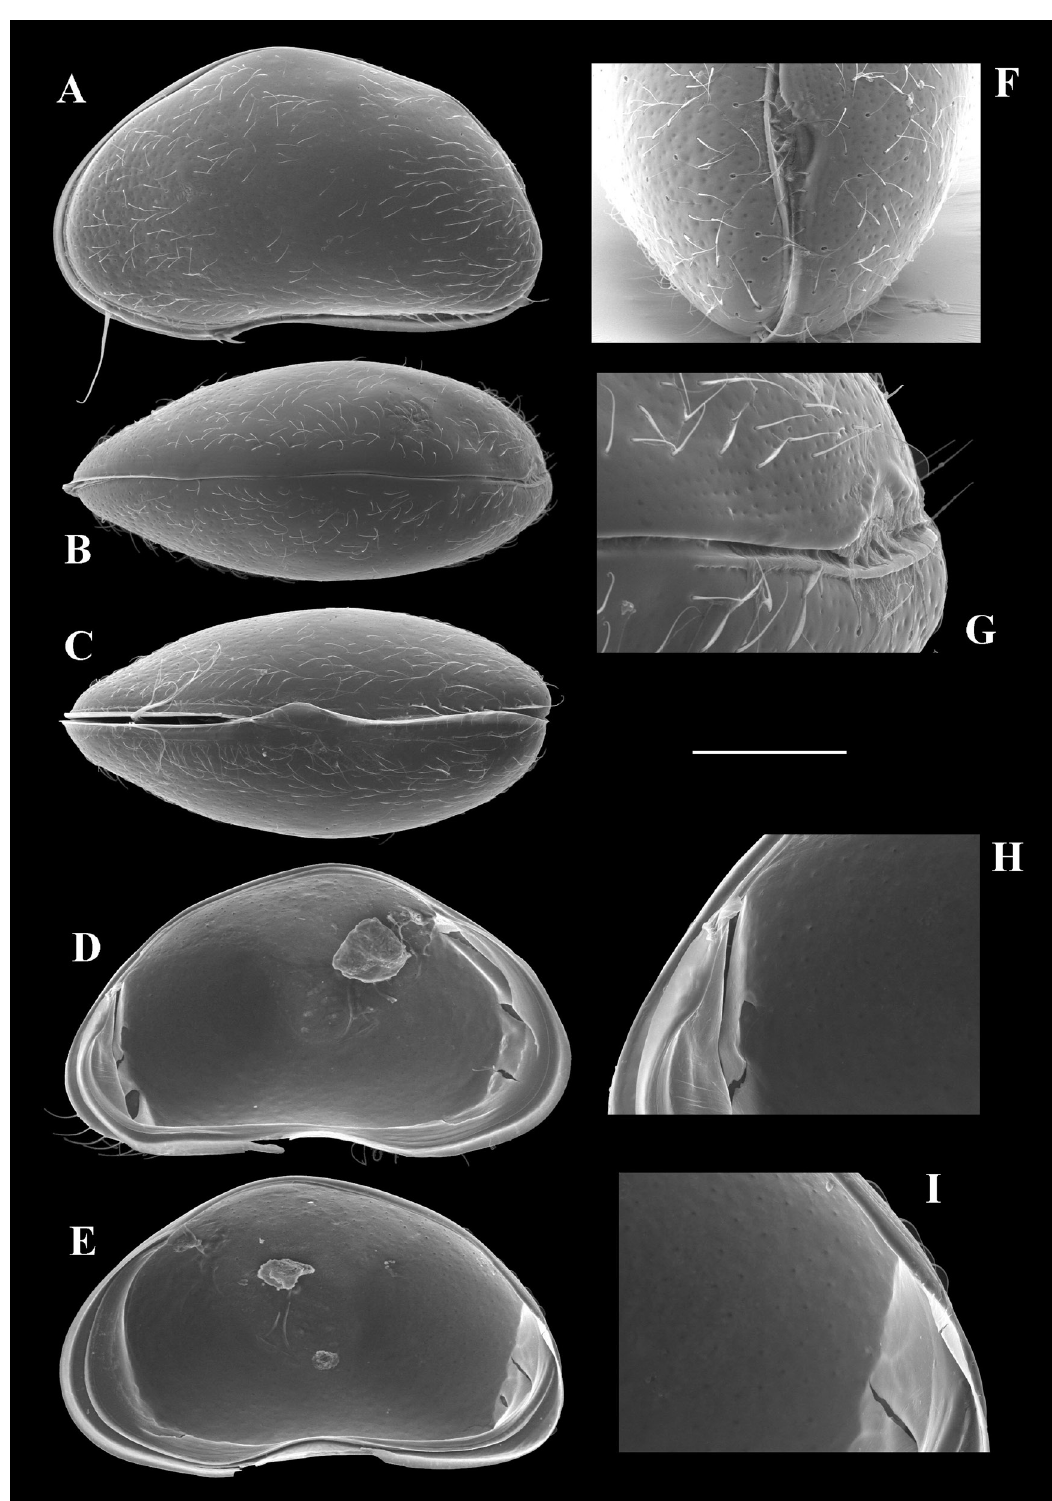
Fig. 1. Siamopsis renateae gen. et sp. nov., ♀. A . CpL (MSU-ZOC.193). B . CpD (MSU-ZOC.194). C . CpV (idem). D . LVi (MSU-ZOC.190). E . RVi (idem). F . CpC (MSU-ZOC.194). G . Posterior end of CpD (idem). H . Postero-dorsal part of LVi (MSU-ZOC.190). I . Postero-dorsal part of RVi (idem). Scale bar: A–E = 200 μm; F = 43 μm; G = 135 μm; H–I = 84